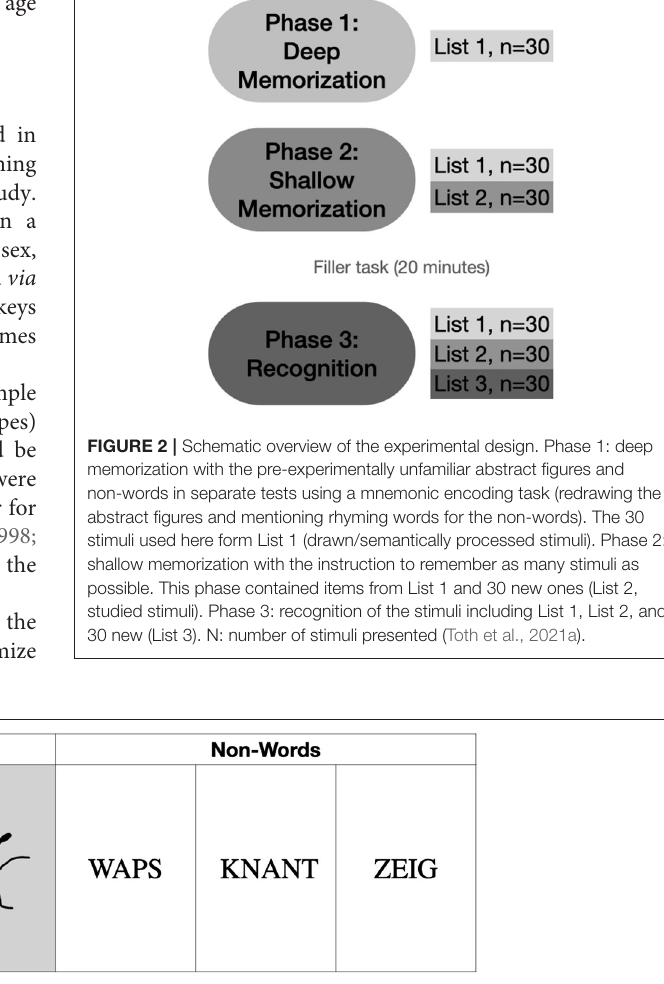
FIGURE 1 | Examples of the stimuli